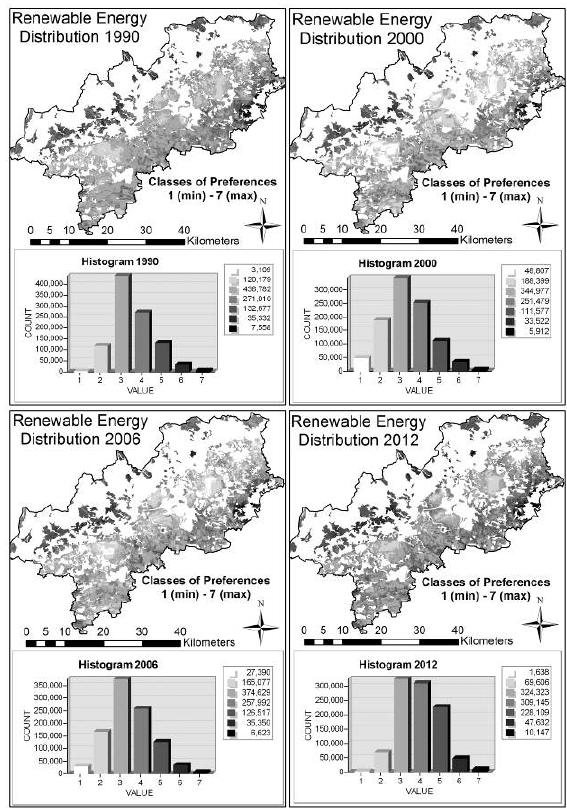
Figure 10. Mapping of the energy potential on the scale preference classes (1-7), where the first class is linked to minimum and the last class to maximum